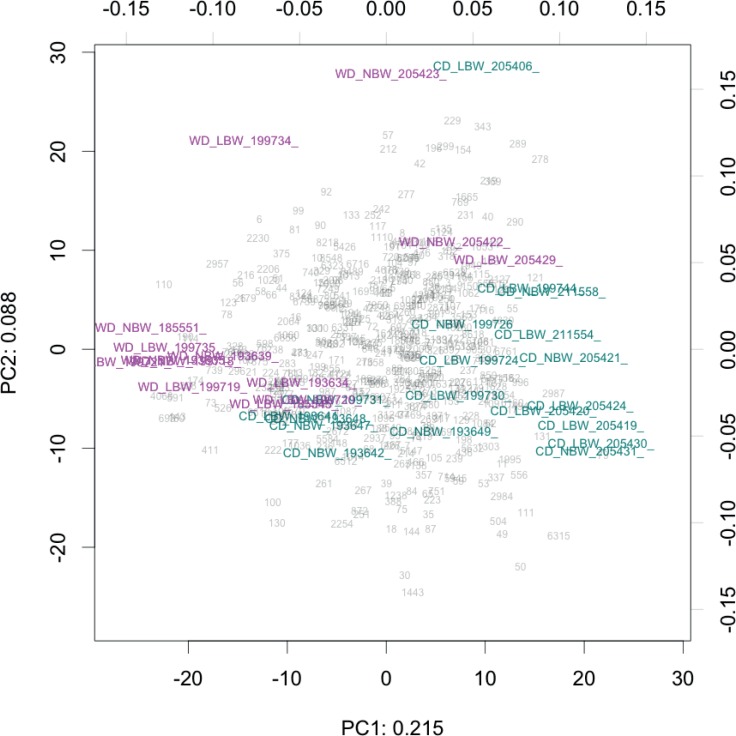
Compositional biplot of all samples.Samples are coloured according to diet, OTUs are shown as grey numbers. Approximately 30% of the variance is explained in the first two components. The biplot is drawn to show the relationship between the samples (scale = 0), as opposed to OTUs.